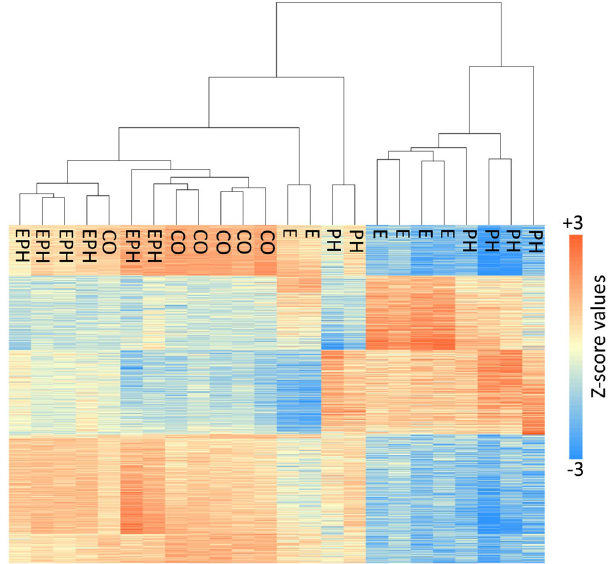
Figure 1. Heatmap of the standardized FPKM gene expression, showing relative levels of abundance of transcripts across the control ( CO ), embryonic ( E ), post-hatch ( PH ) and embryonic and post-hatch ( EPH ) treatment individuals for genes with greater than 1.5 fold-change difference in expression.